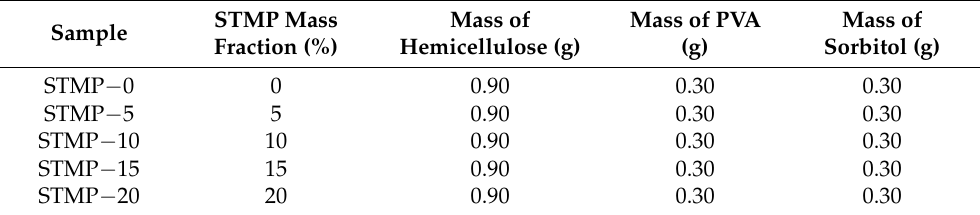
Table 1. Nomenclature and composition of films.